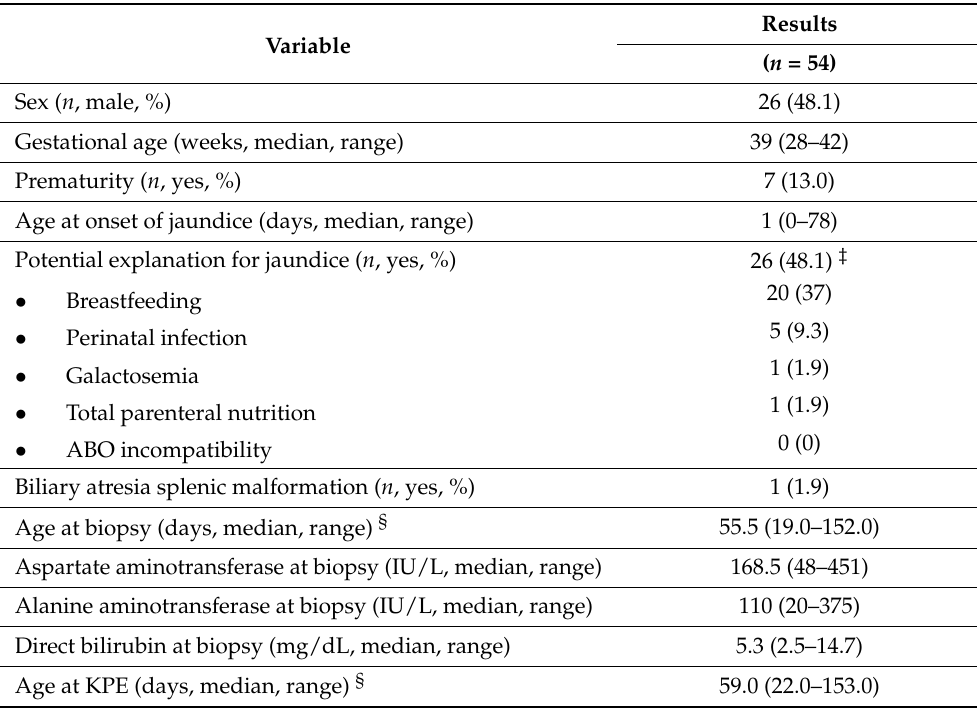
Table 2. Descriptive statistics of the study population (Legend: KPE: Kasai portoenterostomy; (‡) One patient was both breastfed and thought to have a perinatal infection; (§) Non-corrected age for prematurely born